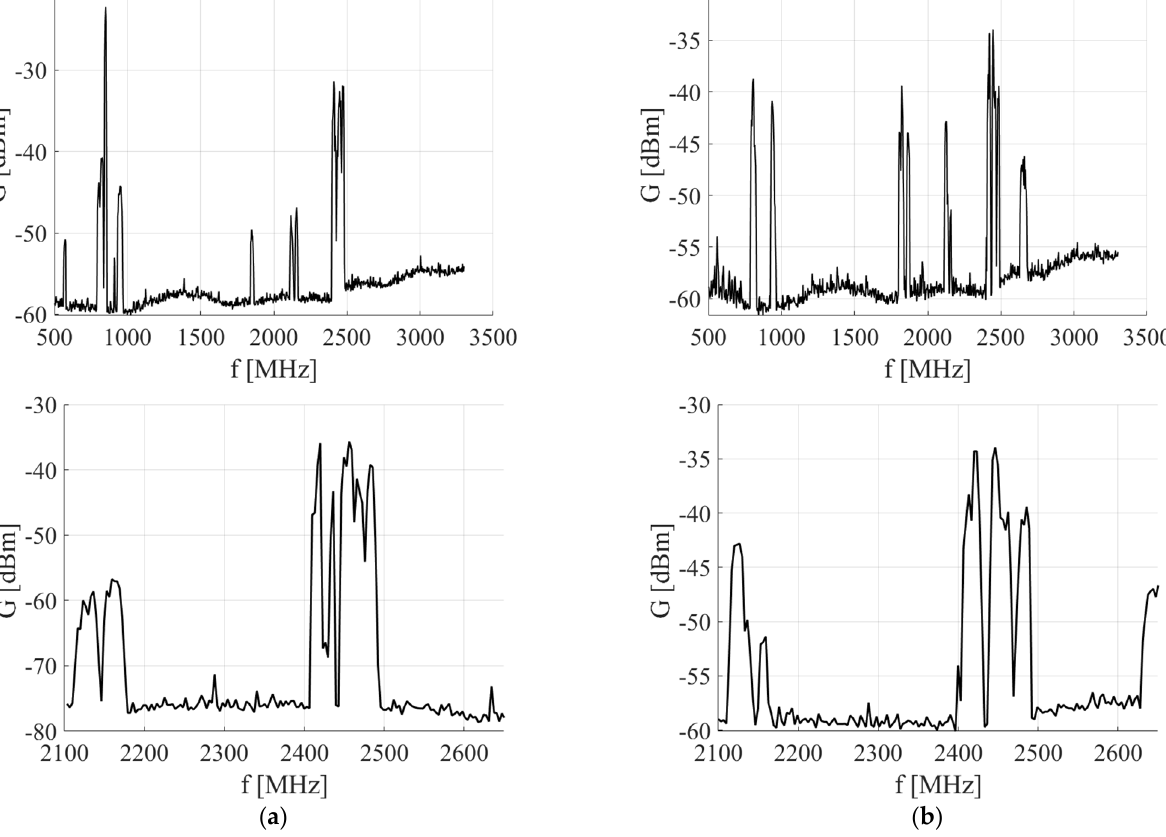
Figure 12. Example of EMF received power of whole spectrum (upper graph) and spectrum in measured frequency band (lower graph) ( a ) CAR A, and ( b ) CAR B. Table 3. Maximum values of electric field strength measured in CAR A and B.